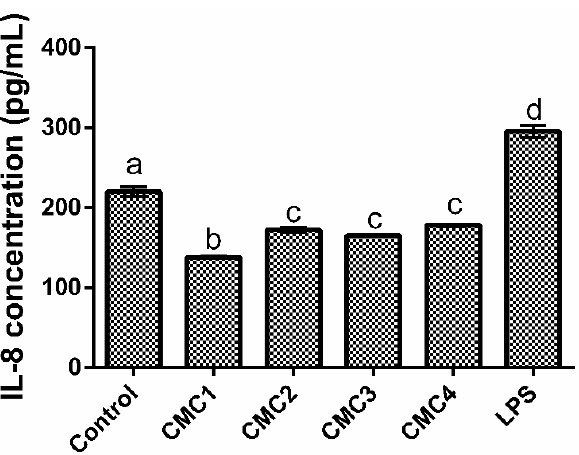
Figure 7. IL-8 production in HaCaT cells in the presence of CMC relative to the basal level (control). Different letters represent the statistically significant differences ( p < 0.05) found between condi- tions.